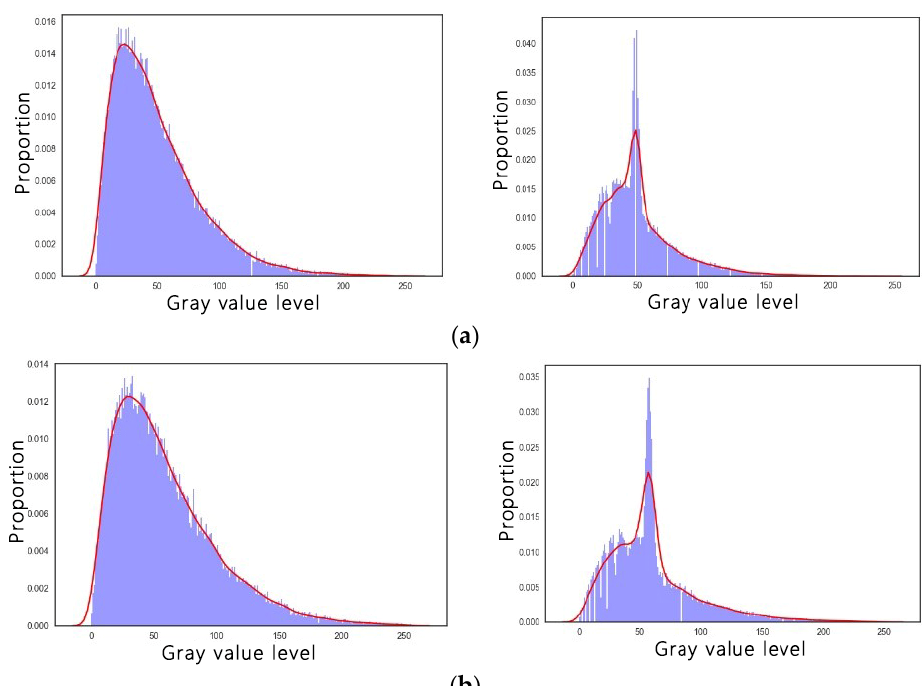
Figure 7. Histogram and probability density curve of the gray compressed image: ( a ) contrast histogram of the gray 50 noise image before and after compression; ( b ) contrast histogram of the gray 60 noise image before and after compression.